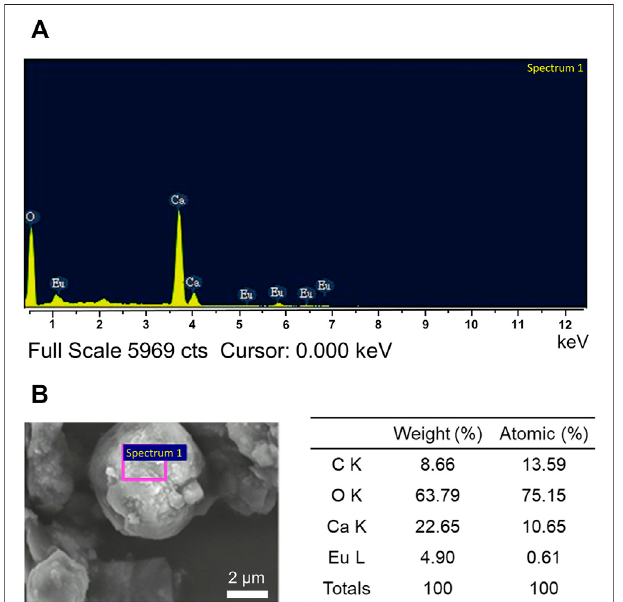
FIGURE5|(A) ThechemicalcompositionofthesynthesizedCaCO 3 :Eu by EDS, and (B) the weight percentage and atomic percentage in average of each element.